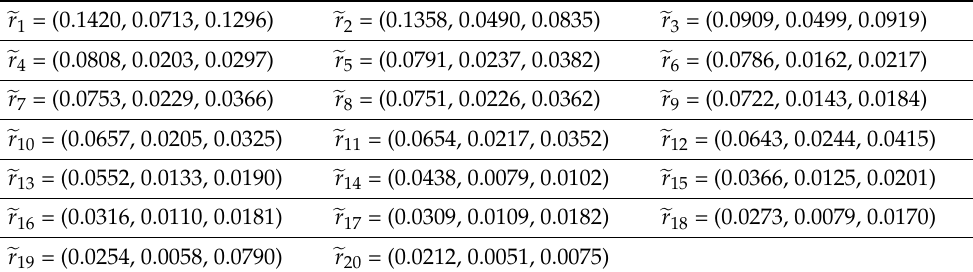
Table 5. The fuzzy return of each selected